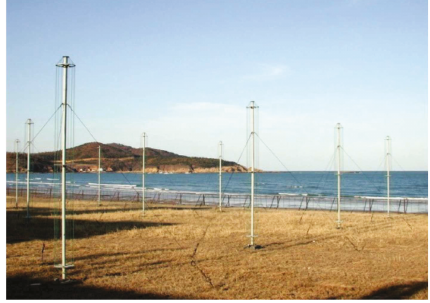
Figure 1: Small-aperture HFSWR system